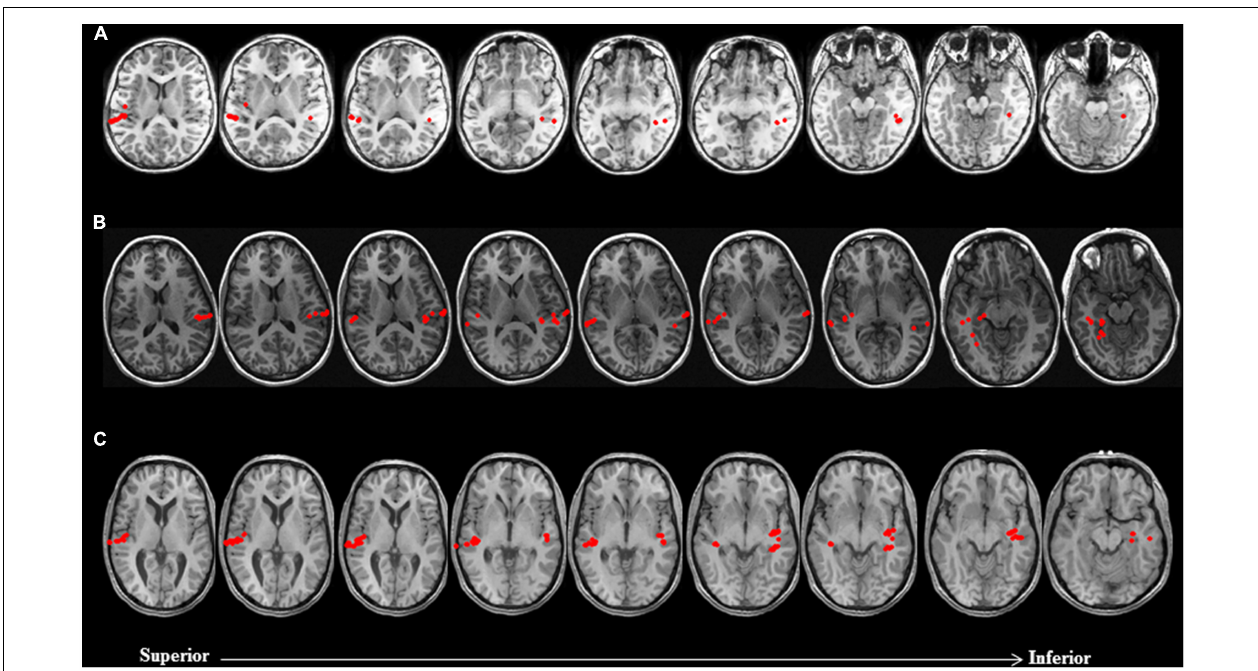
FIGURE 2 | Discordance between laterality judgments based on LI estimates and visual inspection of brain activation profiles in three non-sedated patients. Language activity (dipolar) sources are represented as solid red circles projected onto the patients’ MRI, displayed in radiological convention. (A) 9 year-old female with symptomatic partial epilepsy of left temporal lobe origin was deemed to be right dominant for receptive language based on LI ( − 0.54).Visual inspection of brain activation profiles revealed despite a greater number of activity sources concentrated in the auditory cortex of the right hemisphere, posterior and mesial temporal engagement in the left hemisphere suggested that patient was left dominant for receptive language. (B) 14 year-old female with cryptogenic partial epilepsy of left